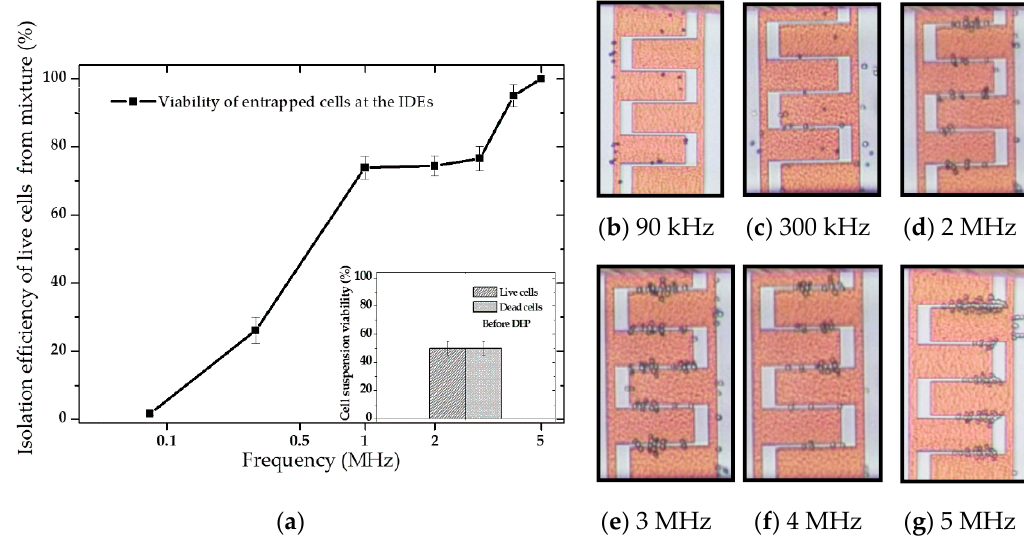
Figure 10. Experimentally recorded results on selectively trapping and separation of live cells from a live and dead yeast mixture (0.1282 S/m) suspended in DIW at a constant voltage of 20 Vpp: ( a ) Isolation efficiency of live cells from a mixture using IDEs; ( b – e ) Micrograph examples where the percentage of isolated live cells increase by increasing frequency ( b ) 0%; ( c ) 22.22%; ( d ) 77.35%; ( e ) 80.19%; ( f ) 91.66%; and ( g ) 100%. White cells are Live, and blue-dyed cells are dead cells. The live and dead cells mixture was 1:1 in the suspension prior to separation.